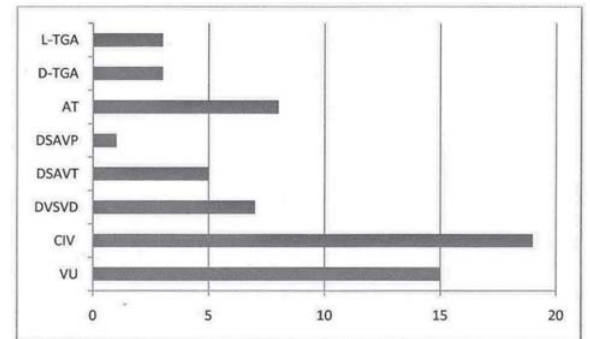
Fig. 1 - Distribuição por cardiopatia. VU = ventrículo único; CIV = Comunicação interventricular; DVSVD = Dupla via de saída do ventrículo direito; DSAVT = Defeito do septo atrioventricular forma total; DSAVP = Defeito do septo atrioventricular forma parcial; AT = Atresia tricúspide; D-TGA = Transposição das grandes artérias; L-TGA = Transposição